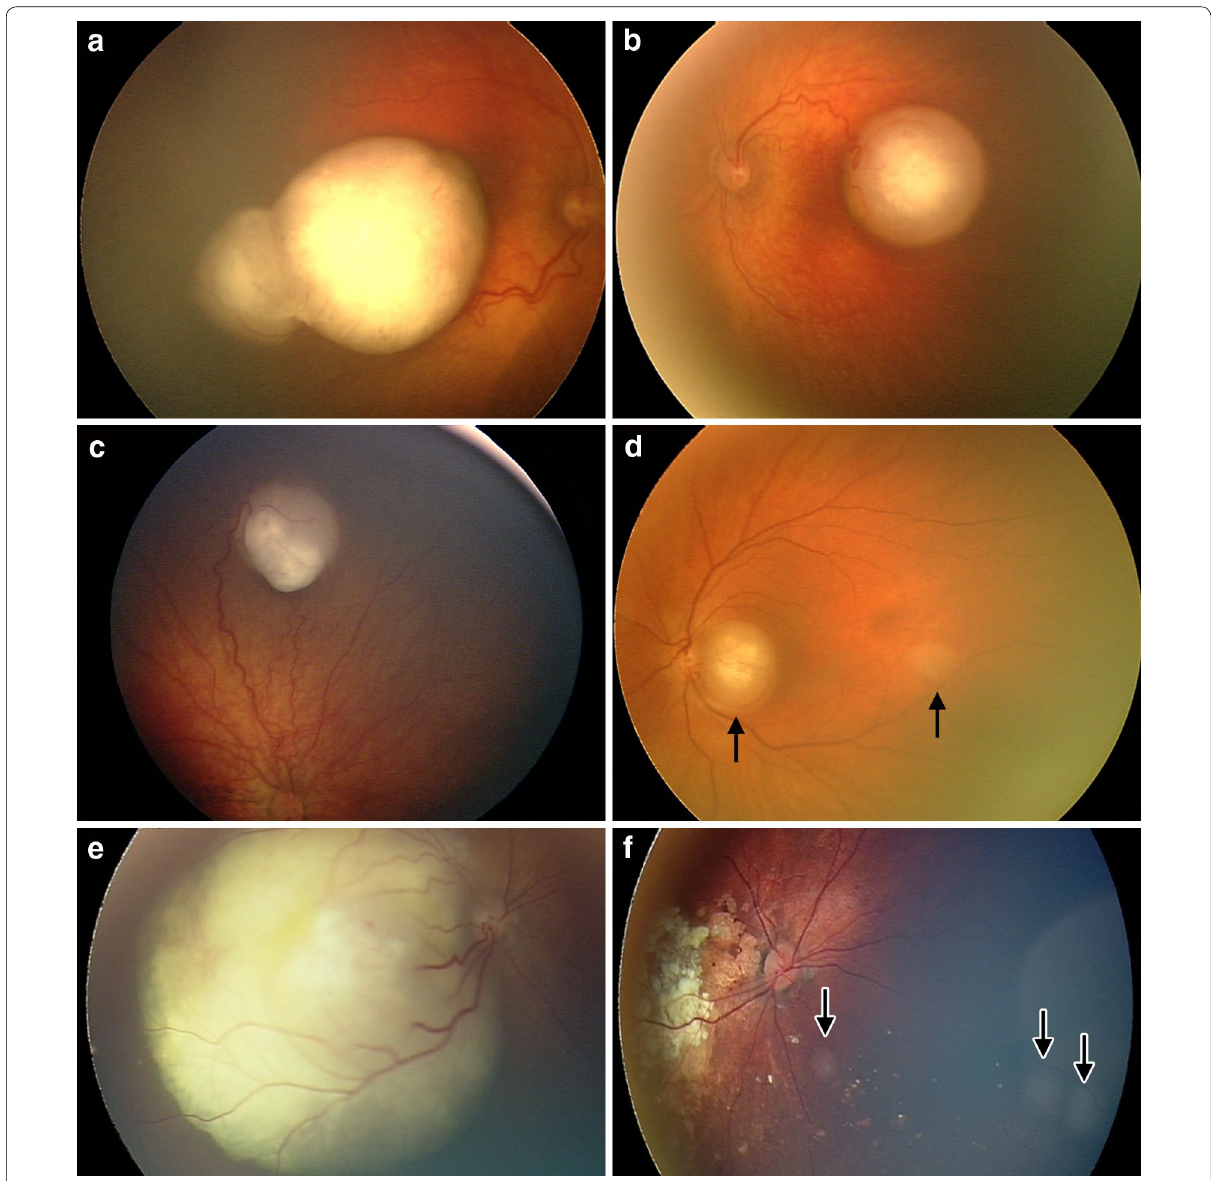
Fig. 3 RetCam images of eyes affected by retinoblastoma. a , b An example of bilateral tumors. Right eye ( a ) presents, with intergrowth between, two initially separate tumors. c Unifocal and d multifocal tumors. Tumor before ( e ), and after ( f ) treatment with intra‑arterial chemotherapy. Note the presence of new multifocal tumors after treatment. Arrows indicate